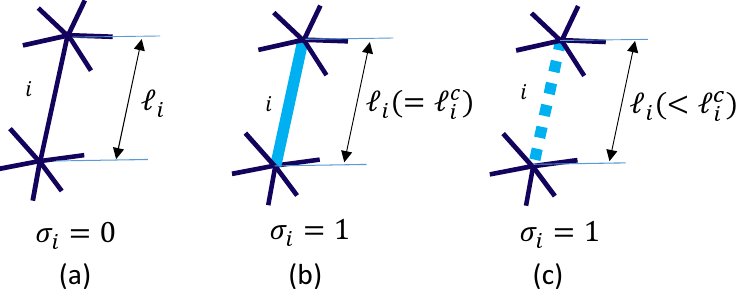
Figure 4. Illustration of the bond i for ( a ) σ i = 0 corresponding to the amorphous bond, ( b ) σ i = 1 corresponding to the rigid bond, and ( c ) σ i = 1 corresponding to the empty